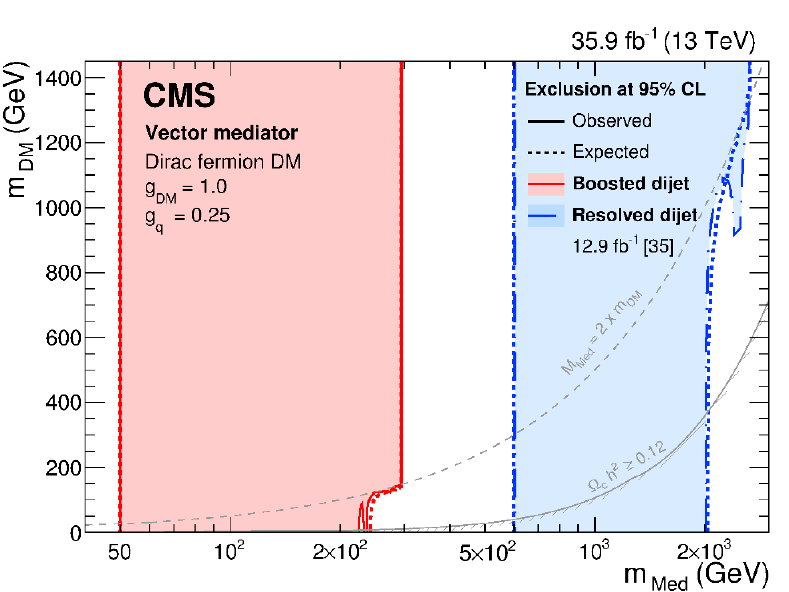
Figure 8 . The 95% CL observed (solid red) and expected (dashed red) excluded regions in the plane of dark matter particle mass ( m DM ) vs. mediator mass ( m Med ), for vector mediators. A branching fraction of 100% is assumed for a leptophobic vector mediator decaying to dijets. The exclusion is computed for a quark coupling choice g q = 0 : 25 and for a dark matter coupling g DM = 1. The excluded regions from the dijet resolved analysis (blue dot dashed lines) using early 2016 data [35] are also shown. Results are compared to constraints from the cosmological relic density of DM (light gray) determined from astrophysical measurements [74, 75] and MadDM version 2.0.6 [76, 77] as described in ref.